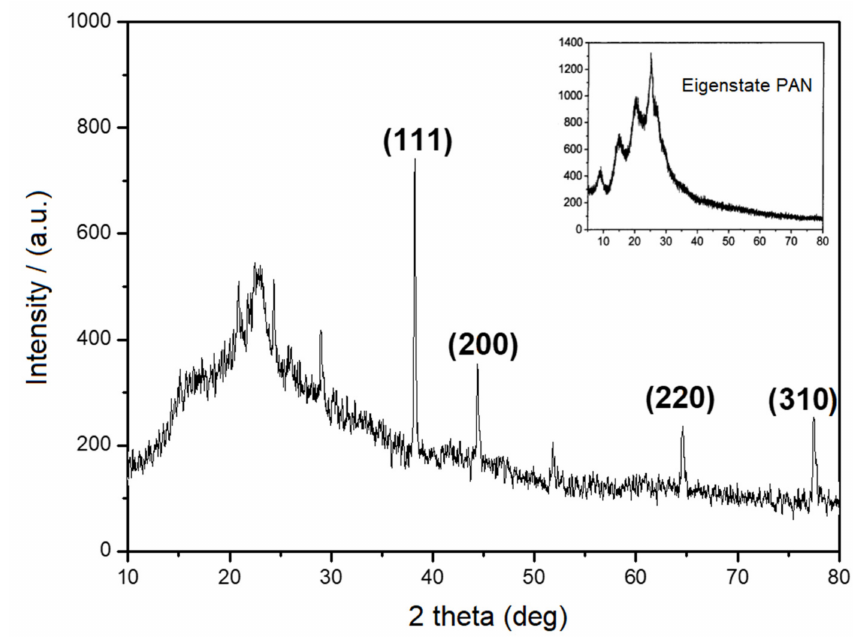
Figure 2. XRD of poly (AN–Ag–S) composite.